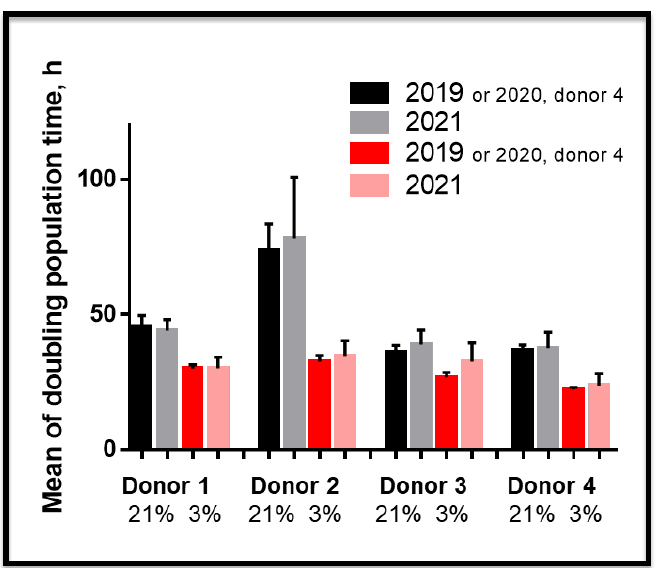
Figure 3. Stability of SCAPs banks over time. Mean + SEM of doubling population time of SCAPs, for the first 10 passages performed at different times as indicated after freeze/thaw processes. All banks, derived and frozen in 2018 (donors 1, 2, 3) or 2020 (donor 4) were frozen/thawed several times (at least 3 times) and then followed for the first 10 passages by thawing passage 1 of each bank.